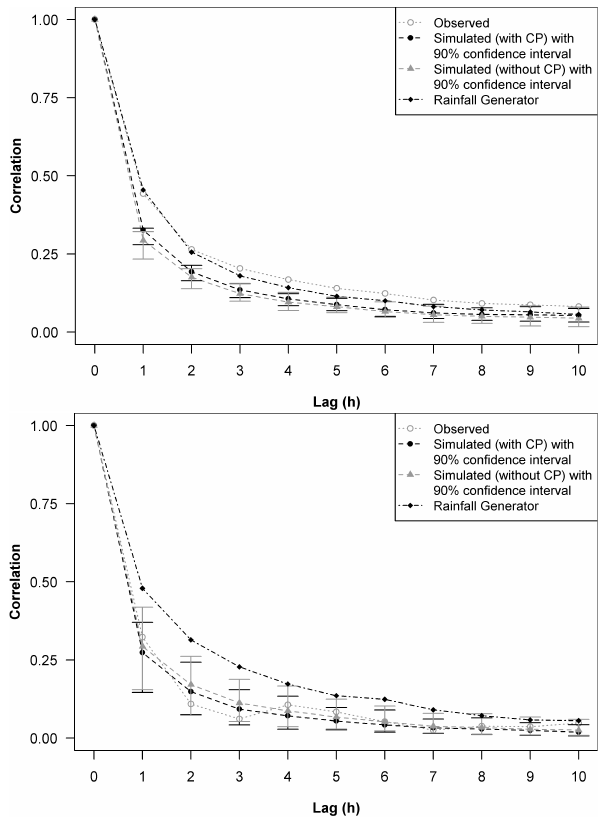
Fig. 10. Autocorrelation function of observed and simulated time series of hourly rainfall data (averaged over 100 disaggregation runs) of cascade models (with and without CP) and the rainfall gen- erator for parameterization period 1989–1999 (top) and validation period 1969–1979 (bottom). For the ensembles generated by the cascade models, 90% confidence intervals are given.